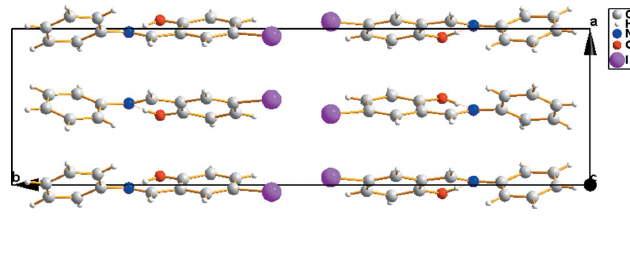
Figure 2 The molecular packing, viewed along the crystallographic c axis.